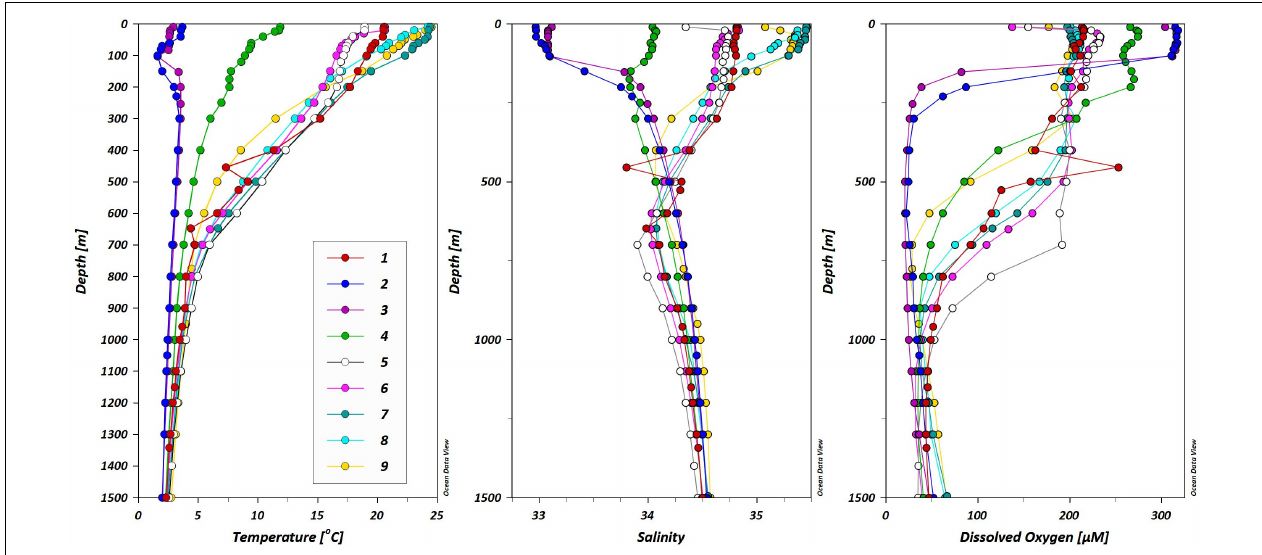
FIGURE 5 | Vertical distributions of physical and chemical properties in the North Pacific Ocean. Station colors match those in the map ( Figure 1 ).